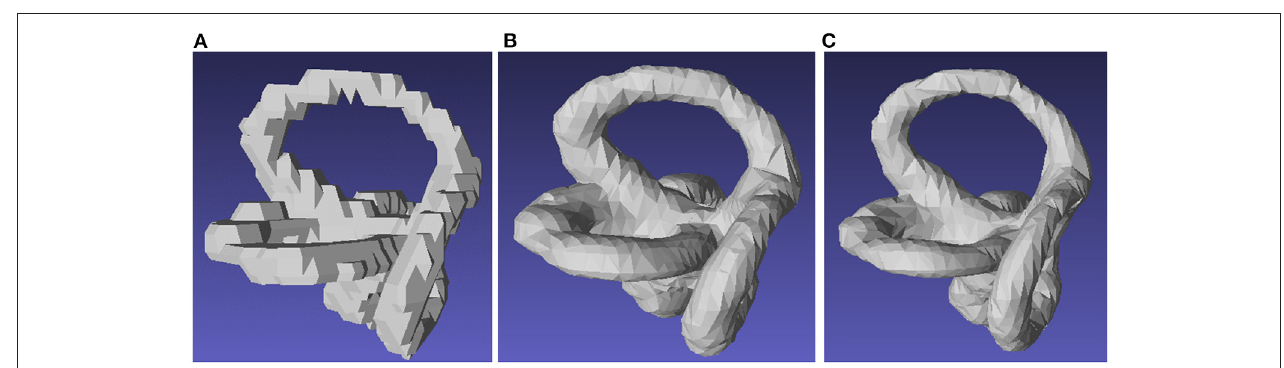
FIGURE 4 | Segmentation of the semicircular canal. (A) Manual segmentation of the semicircular canal. (B) Segmentation of the semicircular canal using the marching cube function. (C) Segmentation of the semicircular canal using a 3D UNET-based deep convolutional neural network.